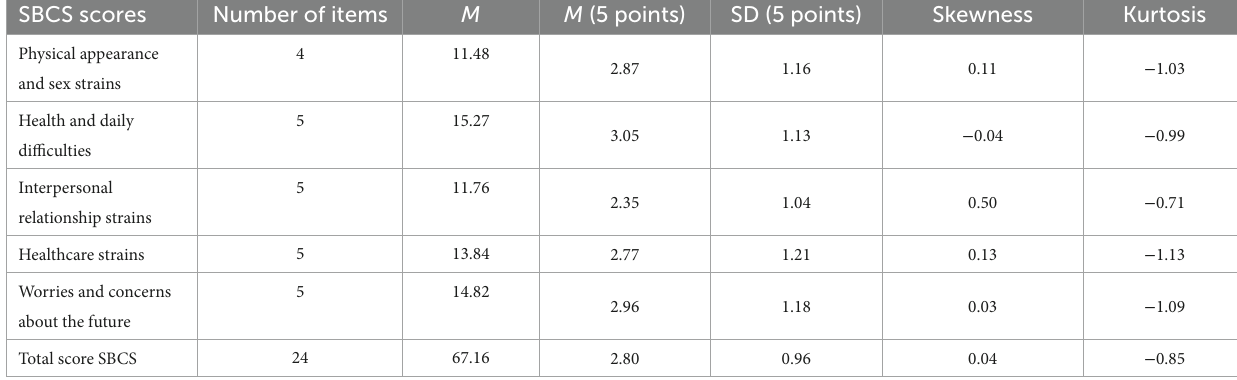
TABLE 8 Means, standard deviations, and skewness and kurtosis for scores on the SBCS (its five dimensions and total, N = 420) calculated as the sum or the mean (5 points) of the respective items. SBCS scores Number of